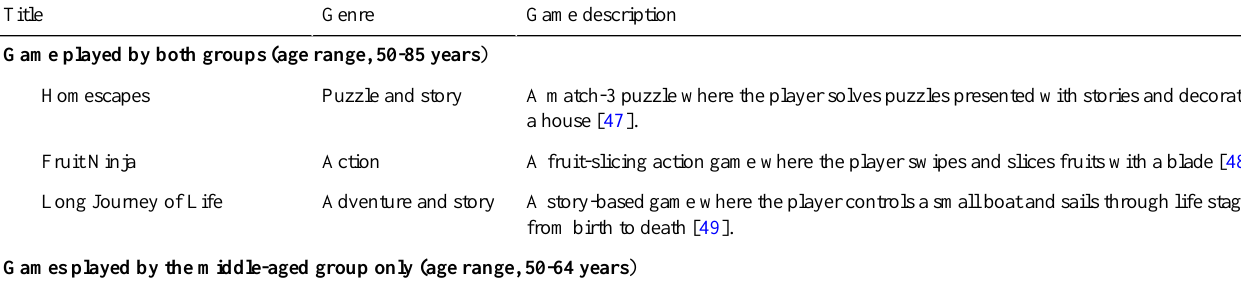
Values, n (%)Characteristic